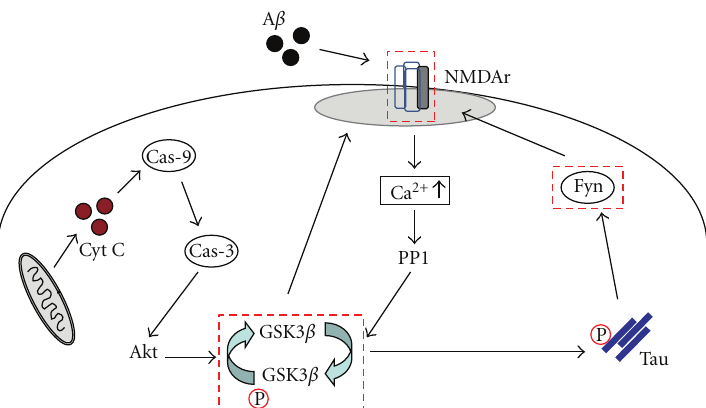
Figure 1: The role of GSK3 β and Fyn during AD-related neurodegeneration and memory formation, along with NMDA receptor, makes them important therapeutic targets (red square). Impairment of hippocampal LTP by A β is through direct interaction with NMDA receptor. Calcium (Ca 2+ ) enters via NMDA receptors and this leads to activation of protein phosphatase 1 (PP1), a key enzyme in synaptically induced LTD. PP1 can dephosphorylate GSK3 β that determines whether NMDA receptor activation induces LTD or inhibits LTD. A β leads to decreased mitochondria and oxidative injury that promotes the release of cytochrome C (Cyt C) that may activate caspase-9 and caspase-3, which can cleave Akt, resulting in GSK3 β activation. GSK3 β under the control of Akt and PP1, is a critical determinant of the direction of NMDA receptor-dependent plasticity. The active GSK3 β isoforms critically contribute to neurodegeneration by hyperphosphorylation of tau which deregulates Fyn activity and consequently a ff ects NMDA receptor